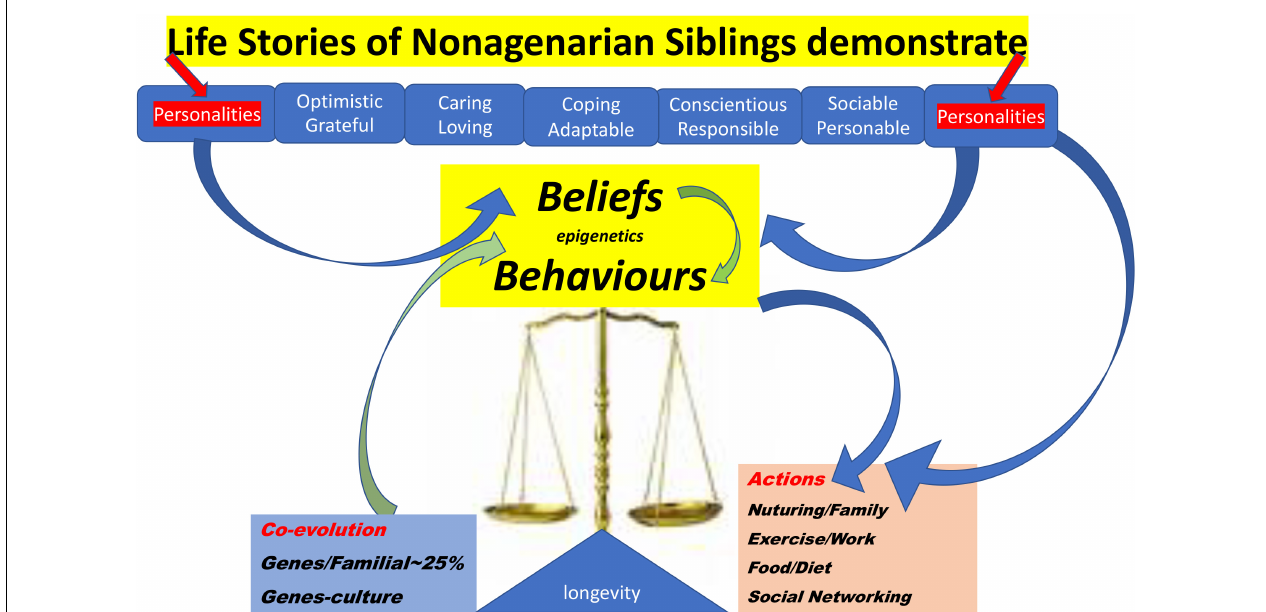
FIGURE 1 | Diagram demonstrating Nonagenarian Sibling Themed Insights into their Longevity, and pathways linking Genes, Beliefs, Behaviours and Epigenetic mechanisms, to Longevity Outcomes.